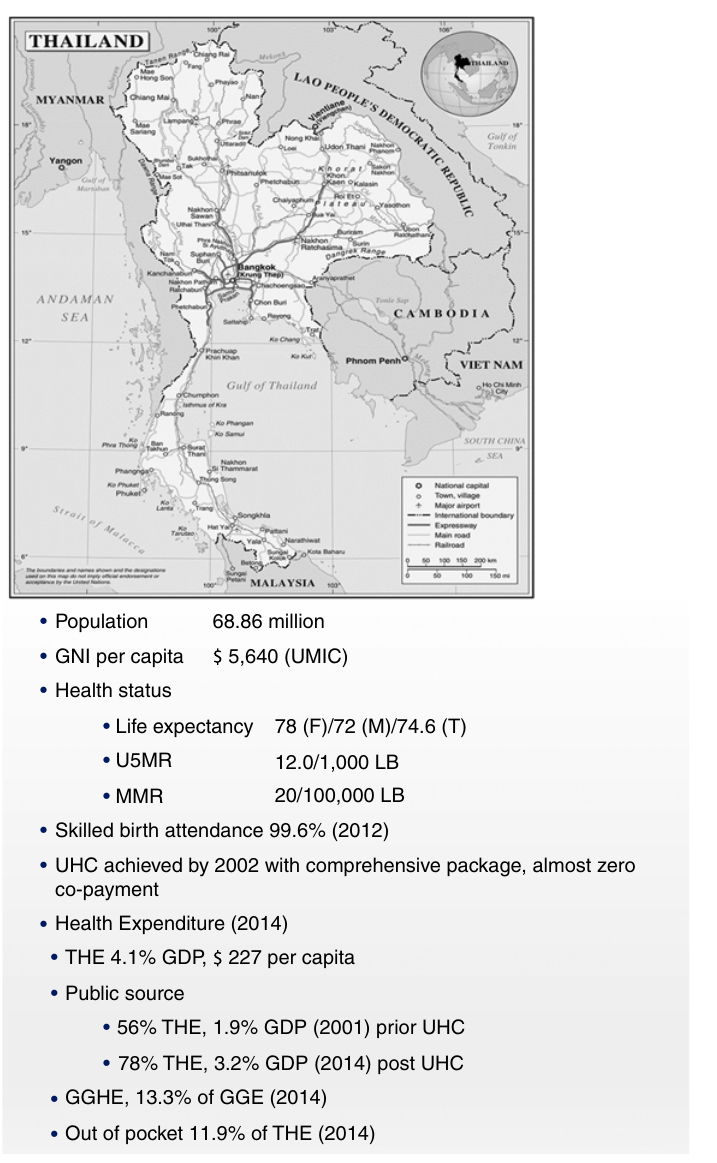
Figure 1. Thailand